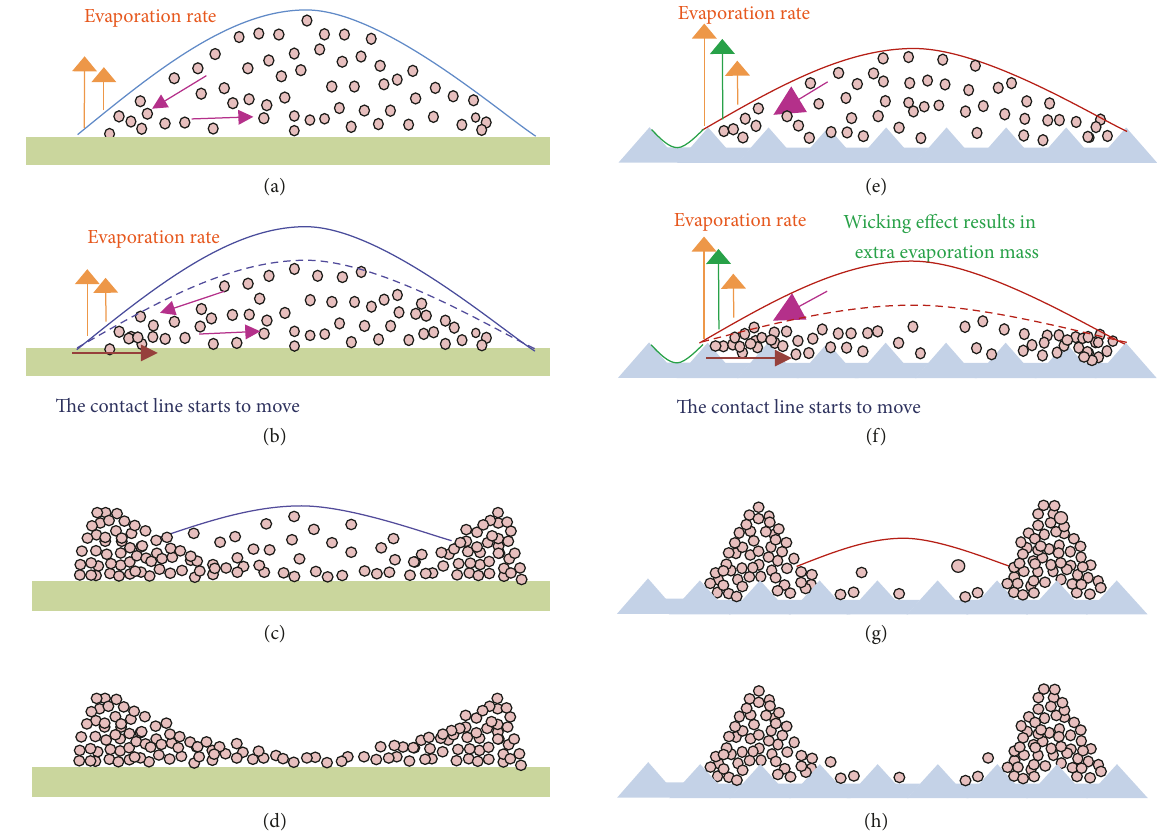
Figure 6: Formation mechanism of evaporation patterns on (a–d) a smooth substrate and (e–h) a rough substrate. (a) On a smooth substrate, the contact angle is larger and the evaporation rate is low; (b) recycling flow is constructed on the smooth substrate; (c) in the later stages of evaporation, many particles remain in the dispersion on the smooth substrate; (d) wedge-shaped cross-section of the deposition; (e) on a rough substrate, the contact angle decreases and the wicking effect emerges, leading to a higher evaporation rate; (f) there is no circumfluence on the rough substrate, with contact angle hysteresis being more evident; (g) almost no particles remain in the center; (h) high-shaped cross- section